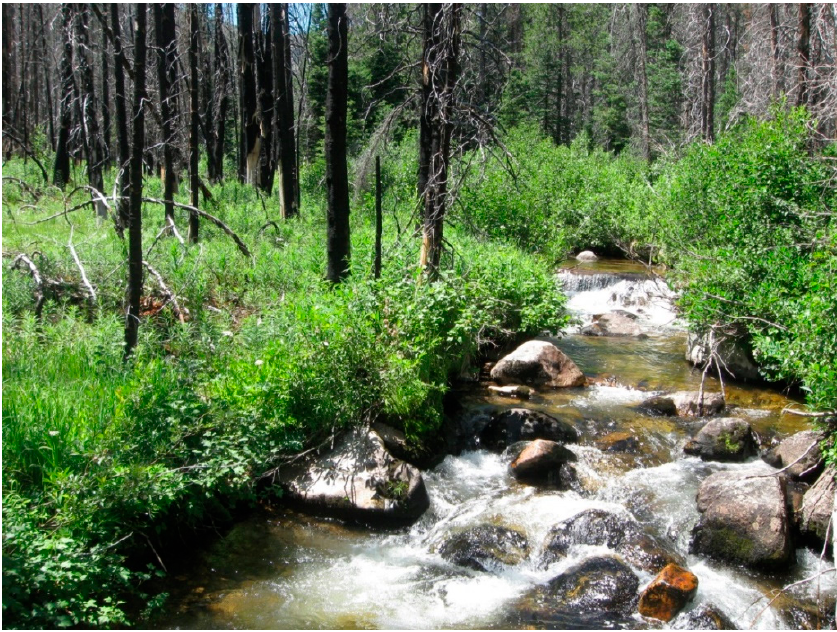
Figure A4. Upstream-reach in summer 2012. This area burned in 2007 after field sampling was com- pleted. Photo by Robert